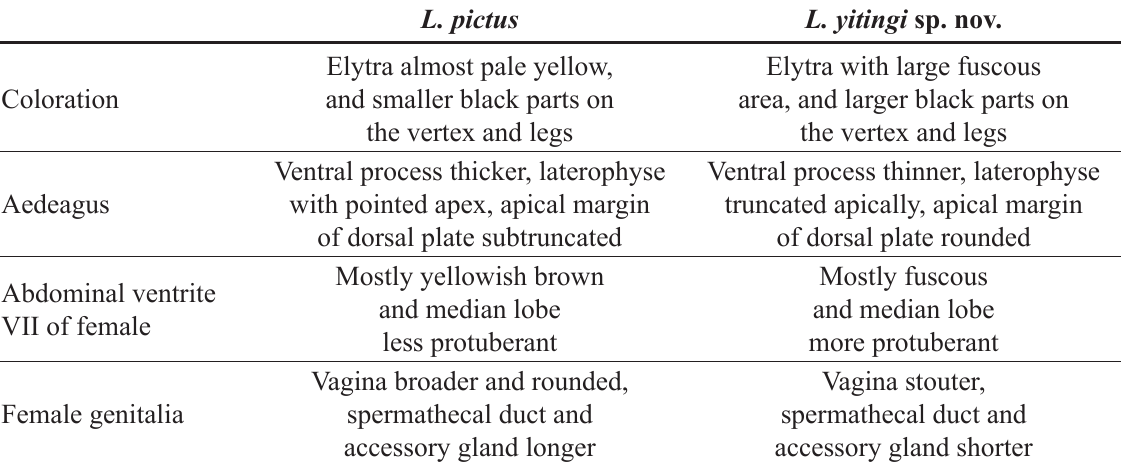
Table 2. Diagnostic characters of Lycocerus pictus (Wittmer, 1983) and L. yitingi Hsiao & Okushima sp.